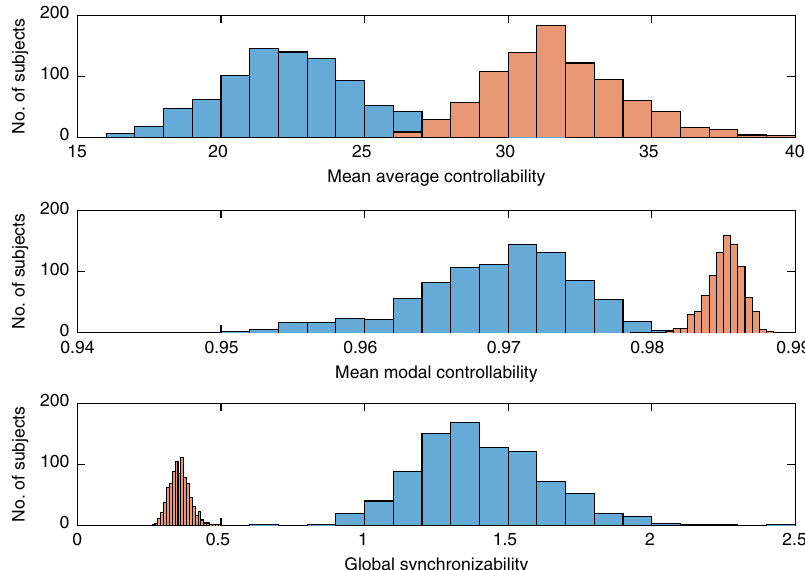
Fig. 5 Brain networks show near-optimal control but fi nite synchronizability. The original brain networks (blue) and fi nal evolved networks (orange) show overlap between their controllability values ( fi rst and second plots), however there is no overlap between the synchronizability values of these two groups (third plot) — suggesting that brain networks display near optimal control but retain a fi nite level of synchronizability